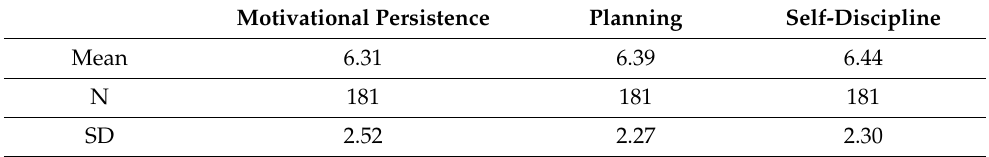
Table 2. Mean and standard deviation of the general scores of psychological